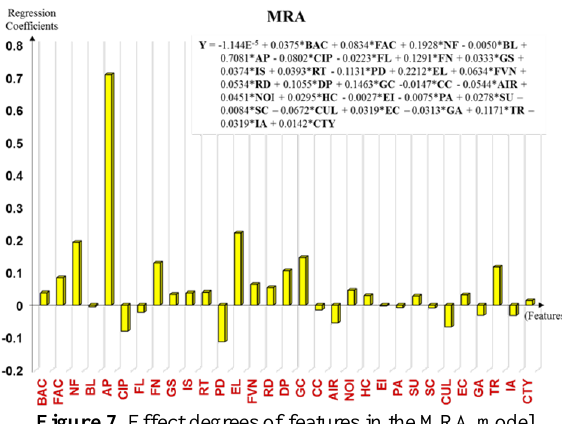
Figure 7 . Effect degrees of features in the MRA model According to findings (Figure 7), there are features that affect the land value as positive or negative. The most effective (positively) feature for the MRA model has been seen as Area of Parcel (AP). The weight coefficient of AP feature in regression was found as 0.7081. The lowest weight coefficient in terms of positive impact has been seen as proximity to the City center (CTY). On the other hand, there are also features that have a negative effect on value. Population Density (PD) appears to be the most effective feature in terms of negative impact. Education Institution (EI) appears to be the most ineffective feature in terms of negative impact. Generally, if the criteria for the RBF-SVR model are ranked in order of importance, from largest to